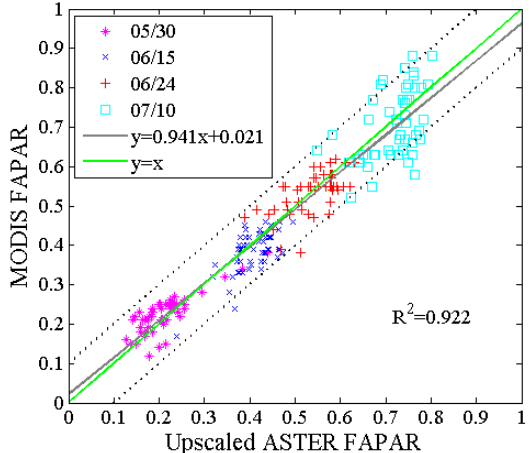
Figure 13. Scatter plot of aggregated ASTER FAPAR and MODIS FAPAR.